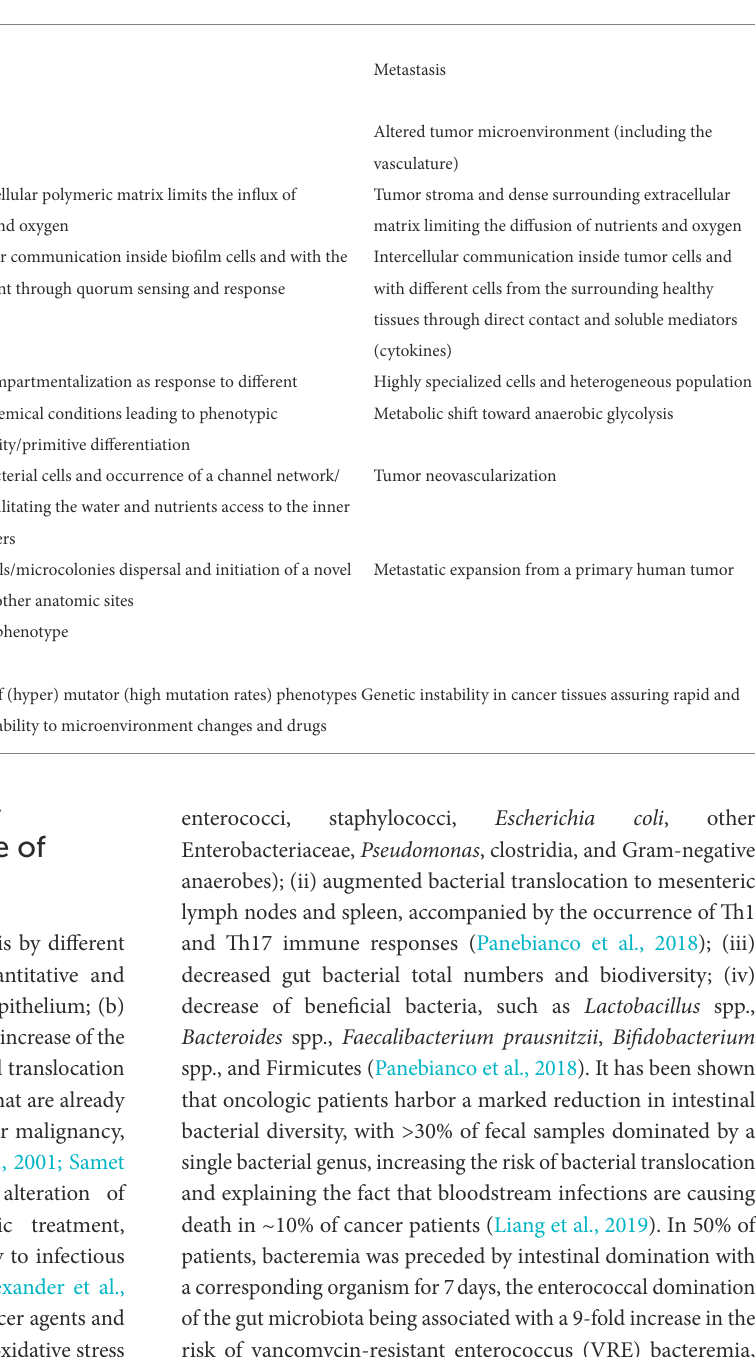
TABLE 1 Summarization of comparative mechanisms adopted by bacterial and tumor cells seeking survival under stress (Lambert et al., 2011). Mechanisms to escape stress mediated by drug exposure